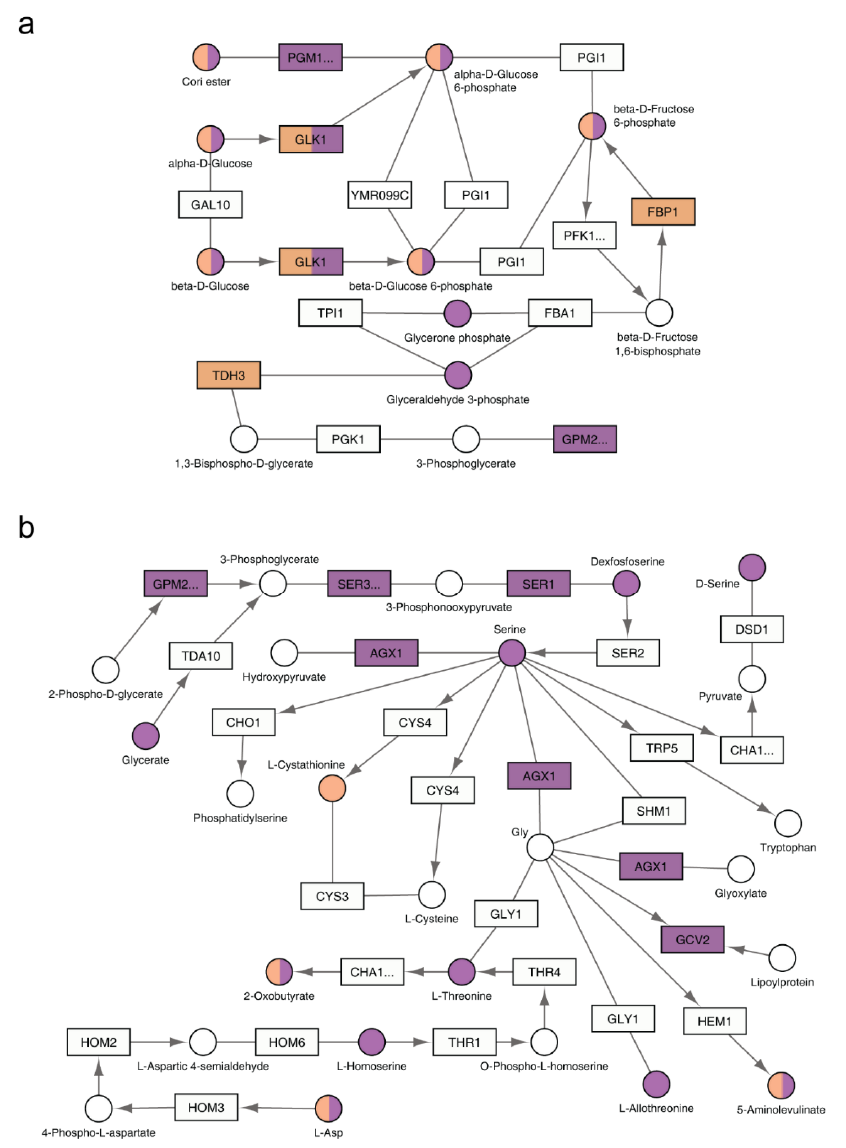
Figure 7. KEGG pathways regulated by GPA2 or RAS2 . The relevant part of a specific KEGG pathway is shown with genes displayed as rectangles and metabolites displayed as circles. KEGG compound name for each metabolite is labeled beside the circle. Standard gene names are labeled inside the rectangle. For enzyme complexes, the gene name for the major component is shown followed with an ellipsis. The directions of irreversible enzymatic reactions are shown by the arrows. Reversible reactions are connected by straight lines. DEGs and SPMs are highlighted in orange ( gpa2 Δ ) and purple ( ras2 Δ ). Shared DEGs and SPMs are colored half orange and half purple. ( a ) both gpa2 Δ and ras2 Δ affected components in glycolysis/gluconeogenesis (functional category: carbohydrate); ( b ) as compared with gpa2 Δ , ras2 Δ affected more components in glycine, serine and threonine metabolism (functional category: amino acid).